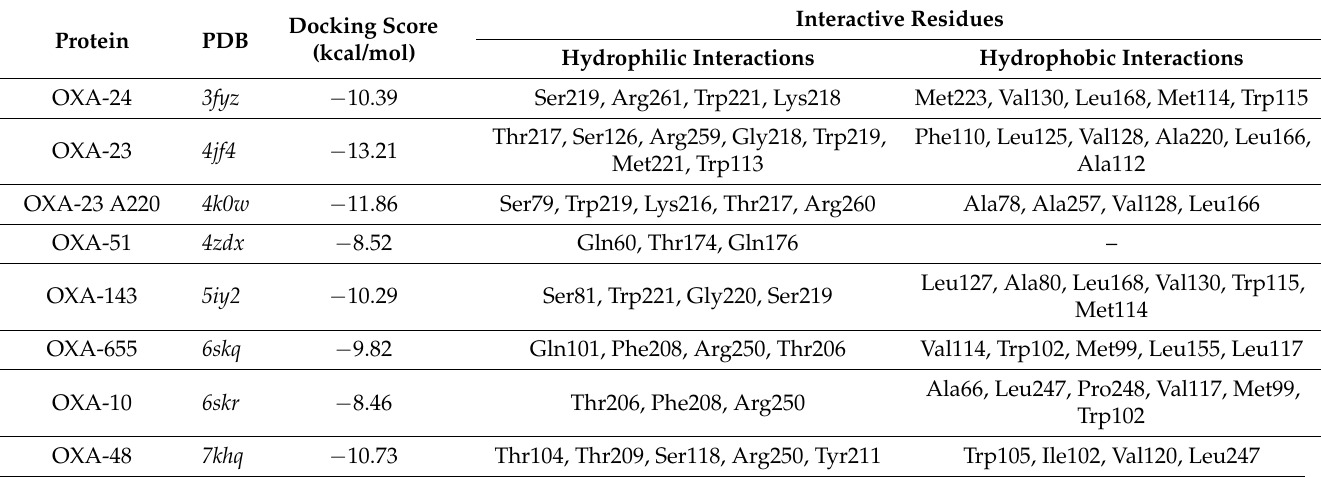
Table 2. Interactions and scores of the docking process of imipenem in OXA beta-lactamase bind- ing